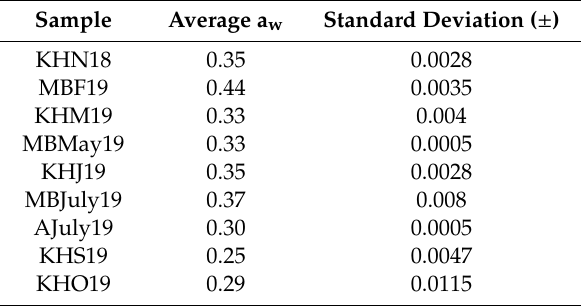
Table 1. Water activity (a w ) measurements of mussel Protamex ® hydrolysates. Nine samples from the three sampling sites, Mulroy bay, Killary harbour and Ardgroom, collected from November 2018 to October 2019, were used for analysis. Analysis was performed in triplicate (n = 3).